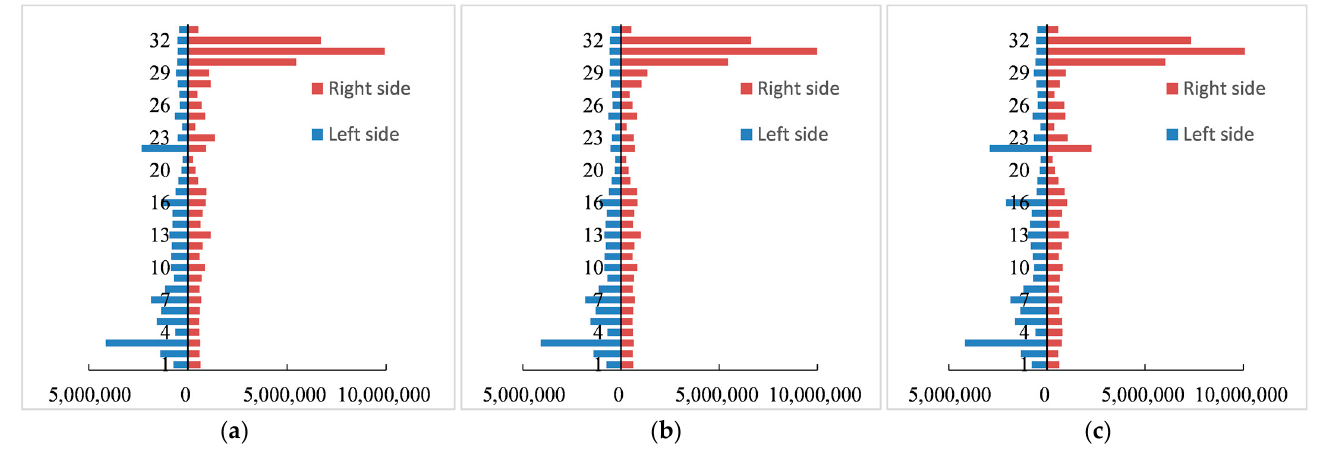
Figure 7. AEV of 32 different sections and different sides. ( a ) AEV in 2000; ( b ) AEV in 2010; ( c ) AEV in 2020.